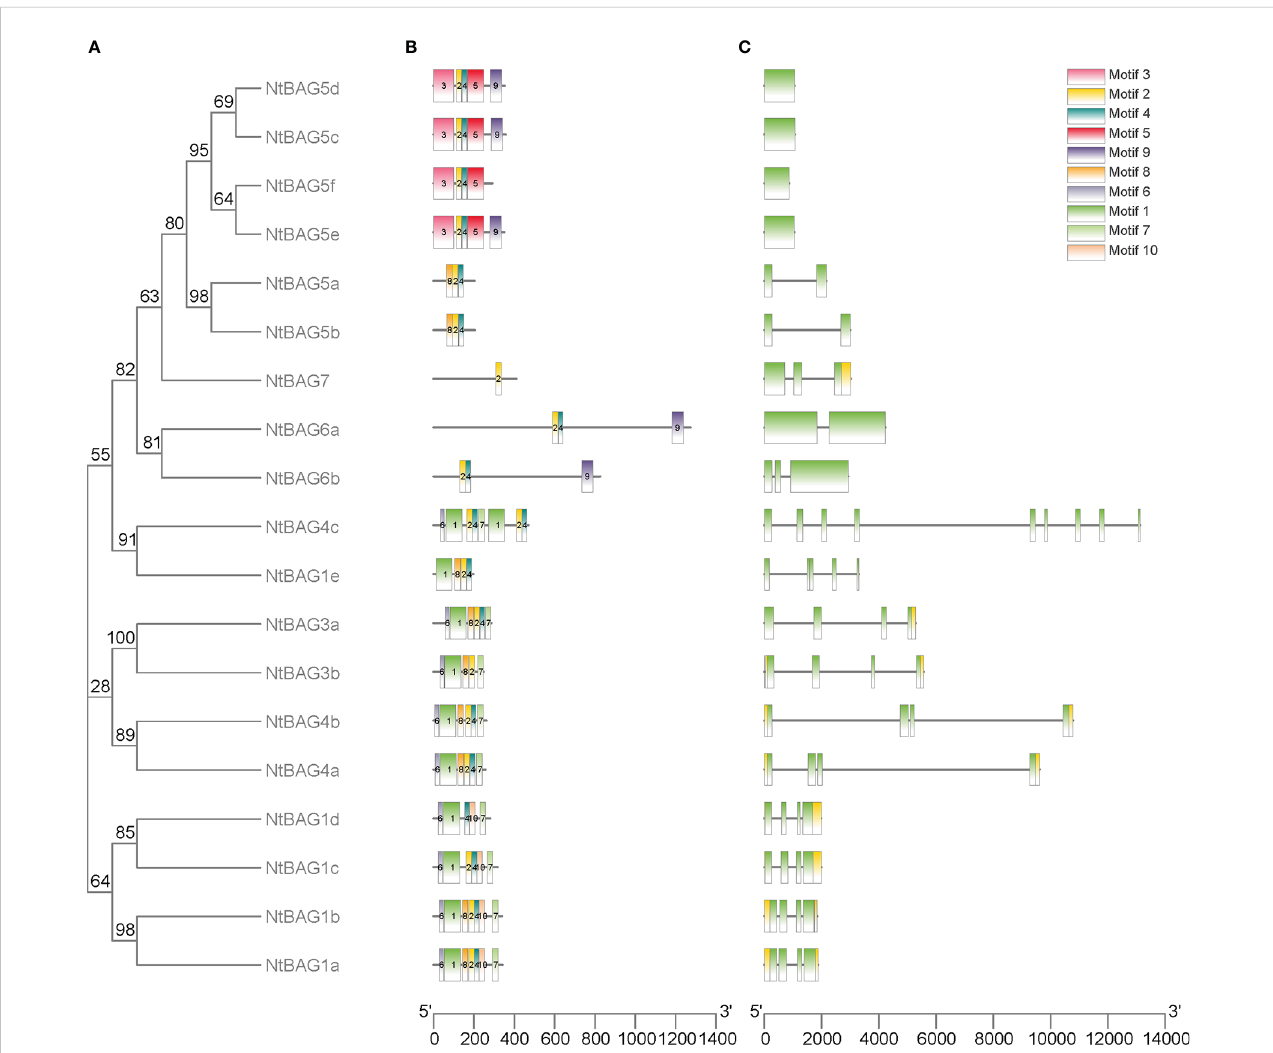
FIGURE 2 Genomic structure and motif composition of NtBAGs. (A) The phylogenetic tree of NtBAG proteins. (B) The conserved motifs in NtBAG proteins were identi fi ed using MEME. Each motif is represented by a speci fi c color and the nucleotide sequence numbers are shown below. (C) Genomic structure of NtBAG family members in tobacco. Exons and introns are represented by green boxes and black lines, while yellow box shows the noncoding